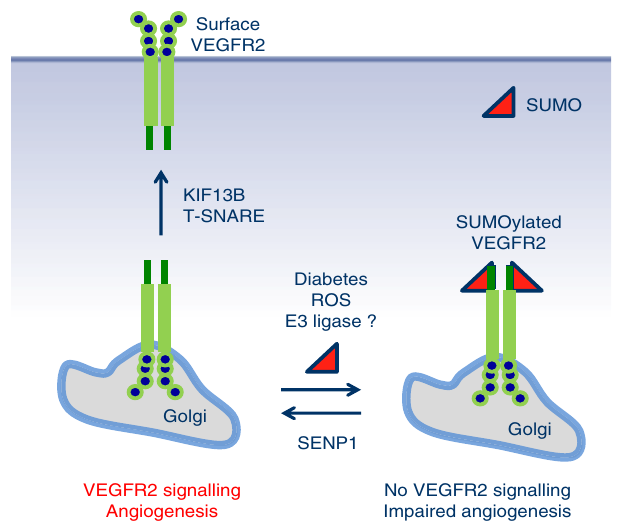
Fig. 8 A model for SENP1-mediated VEGFR2 traf fi cking. SENP1 maintains VEGFR2 in an un-SUMOylated state, ensuring normal traf fi cking of VEGFR2 from ER/Golgi to plasma membrane in EC. We propose that a pool of VEGFR2 is constantly SUMOylated by an unidenti fi ed SUMO E3 ligase in resting EC or upon VEGF-engagement, and stored at the Golgi.